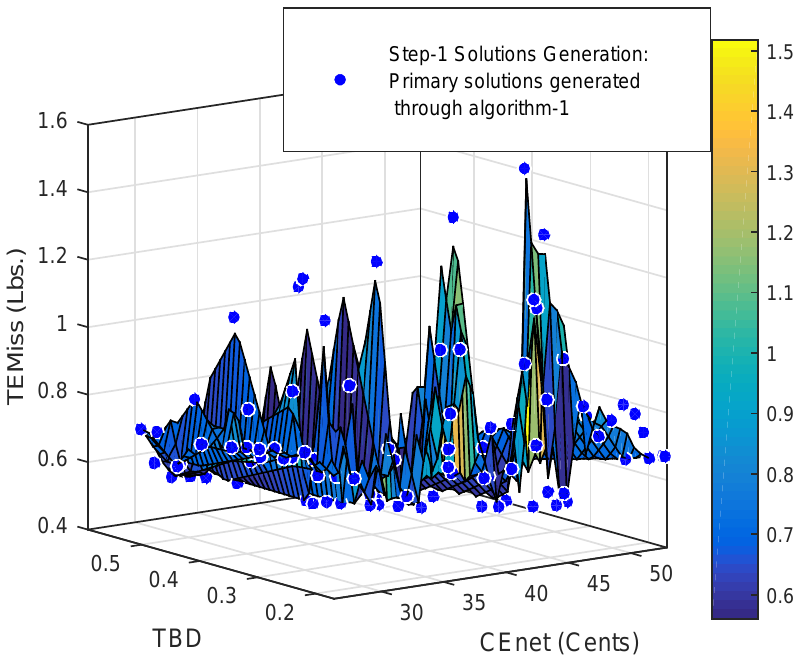
Figure 5. Primary trade-off solutions with un-even surface for TEMiss generated through Algorithm